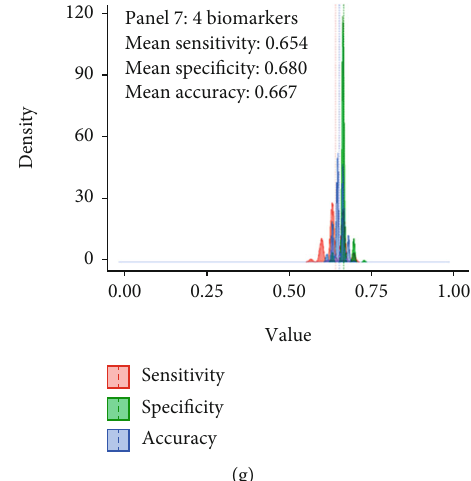
Figure 6: Mean distribution plot for 1,000 iterations from random forest analysis. (a)-(g) The most stable panel with 8 biomarkers which consists of TROVE2, SSB, NDE1, ZHX2, SH3GL1, CARD9, PTPN20, and